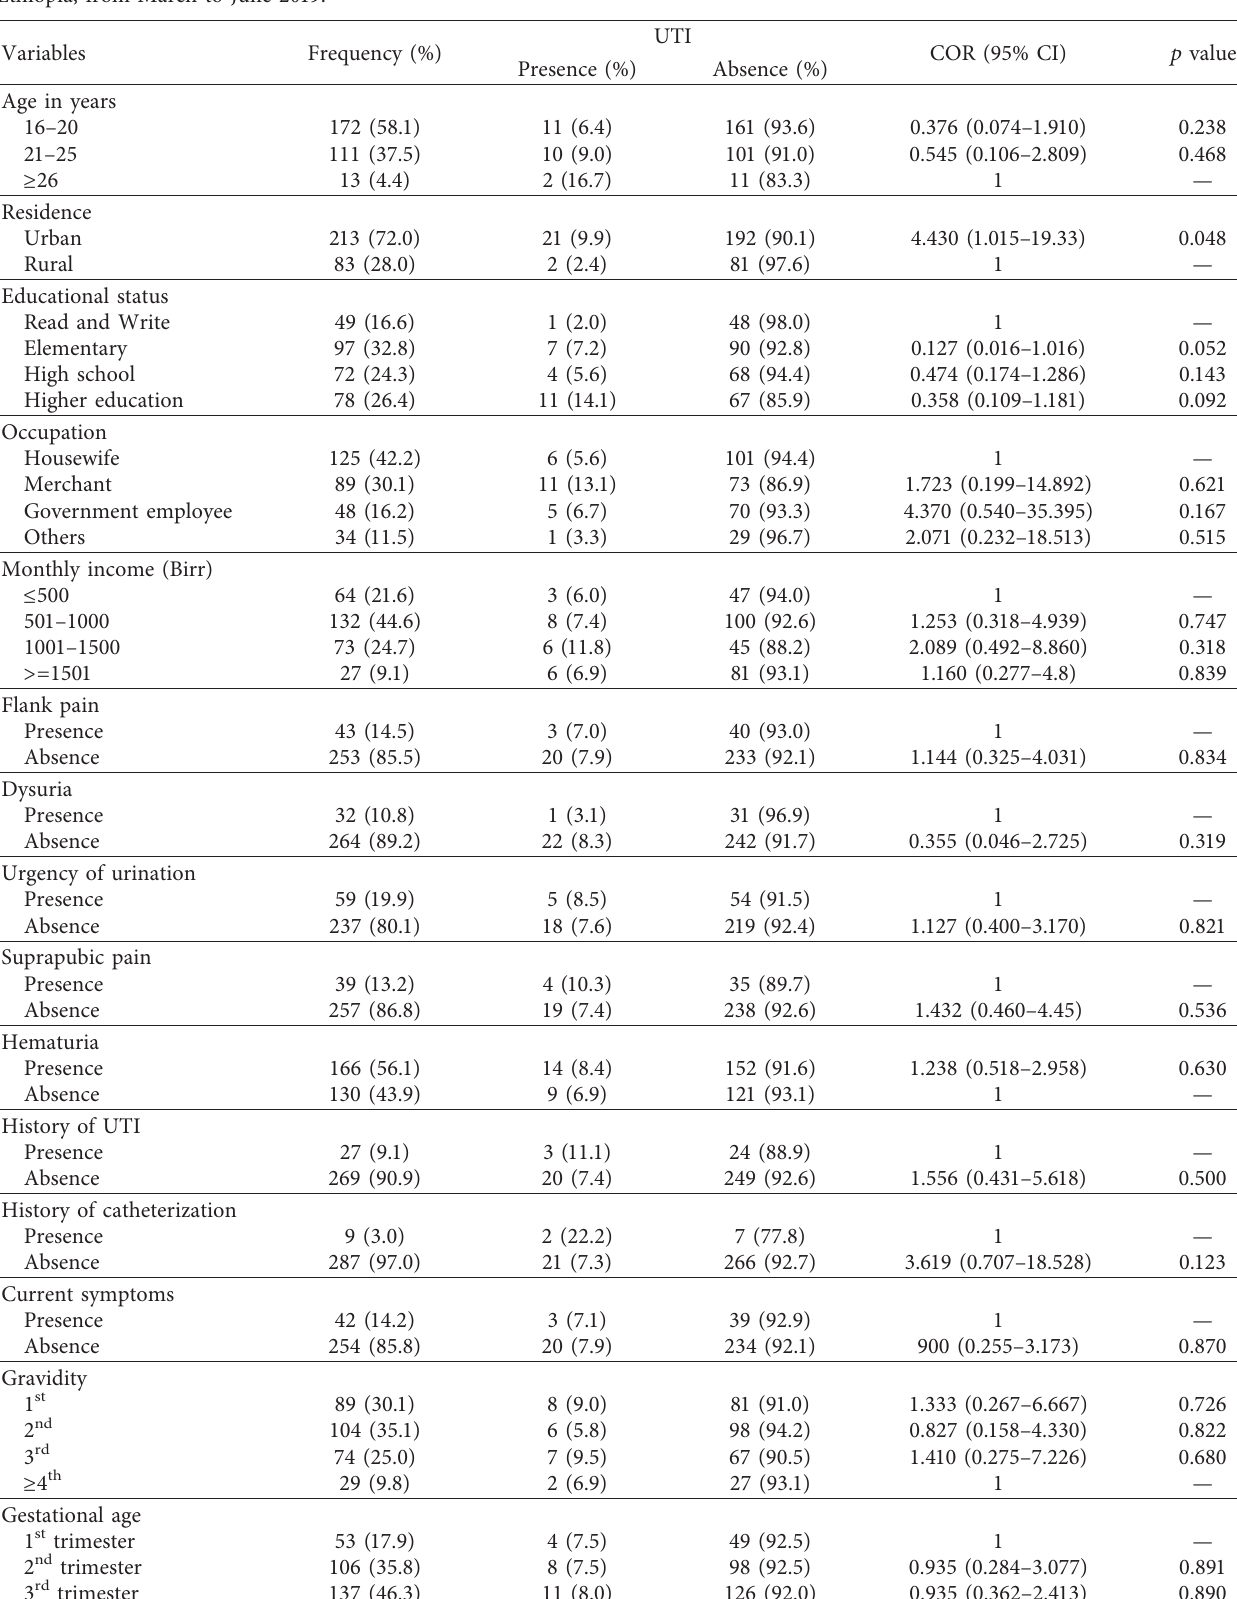
Table 1: Bivariate analysis for the assessment of factors associated with UTI among pregnant women attending ANC at HUCSH, Southern Ethiopia, from March to June